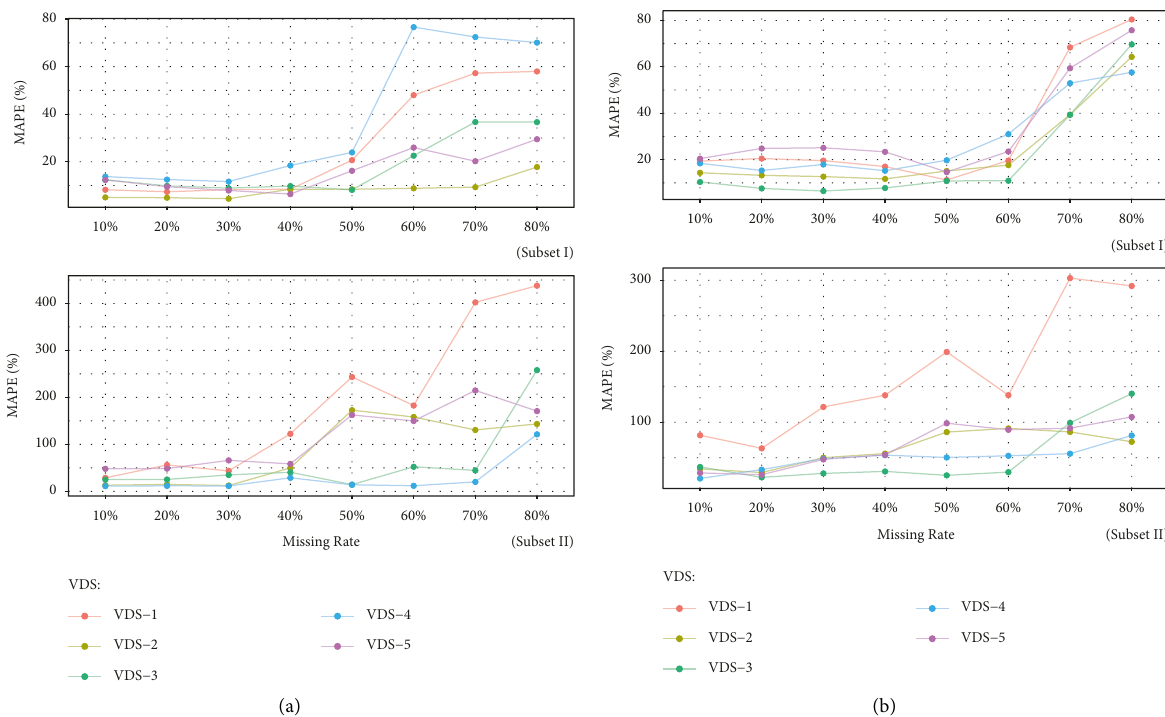
Figure 6: Imputation experimental results of Subset I and Subset II: cross analysis of (a) continuous missing scenarios and (b) jumped missing